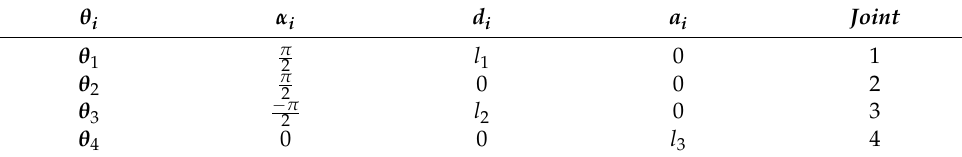
Figure 4. Arm section of the prototype. Table 2. The Denavit–Hartenberg parameters of the arm in Figure